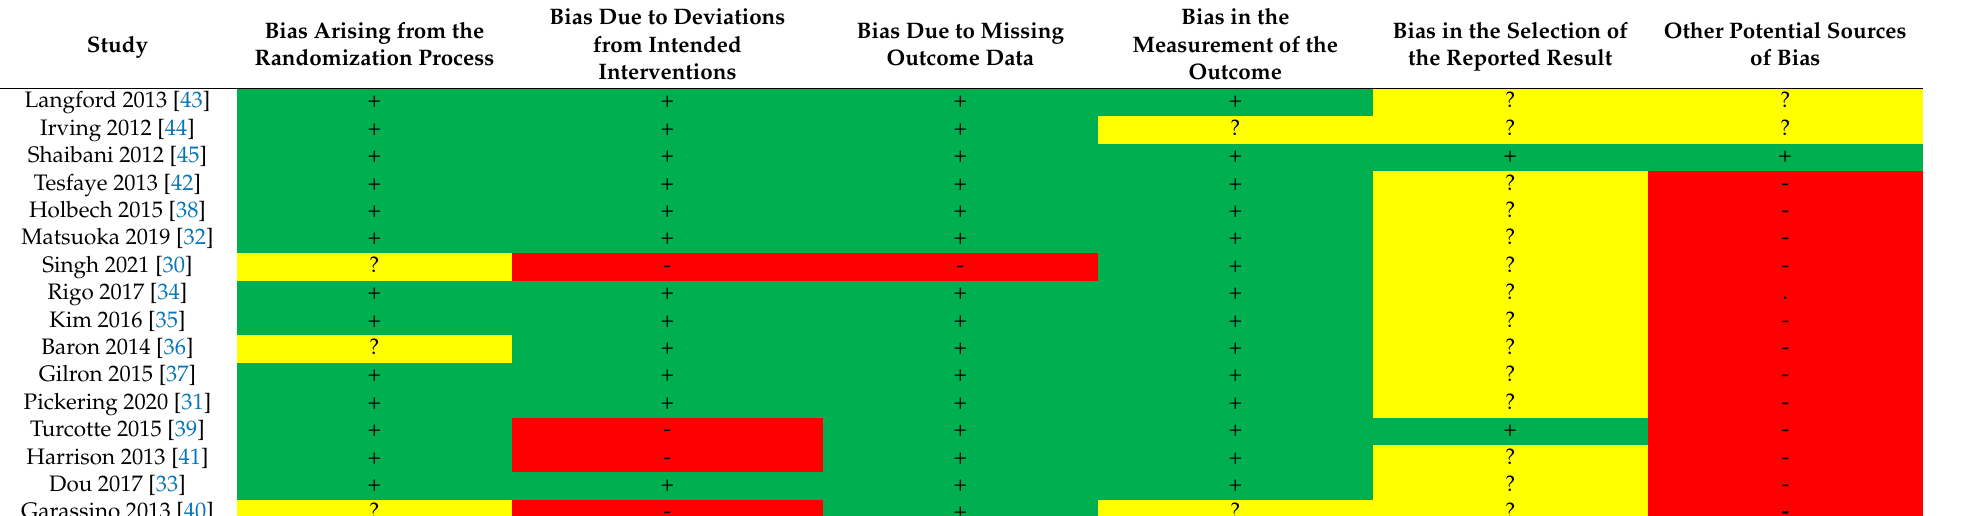
Table 3. Risk of